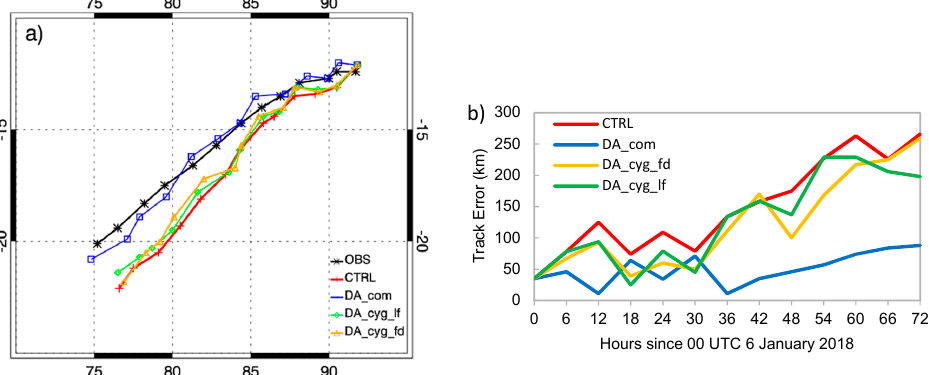
Figure 8. ( a ) TC Irving track from JTWC best track data, CTRL, DA_cyg_fd, DA_cyg_lf, and DA_com and ( b ) track error from CTRL, DA_cyg_fd, DA_cyg_lf, and DA_com at 0000 UTC on 6–9 January 2018.